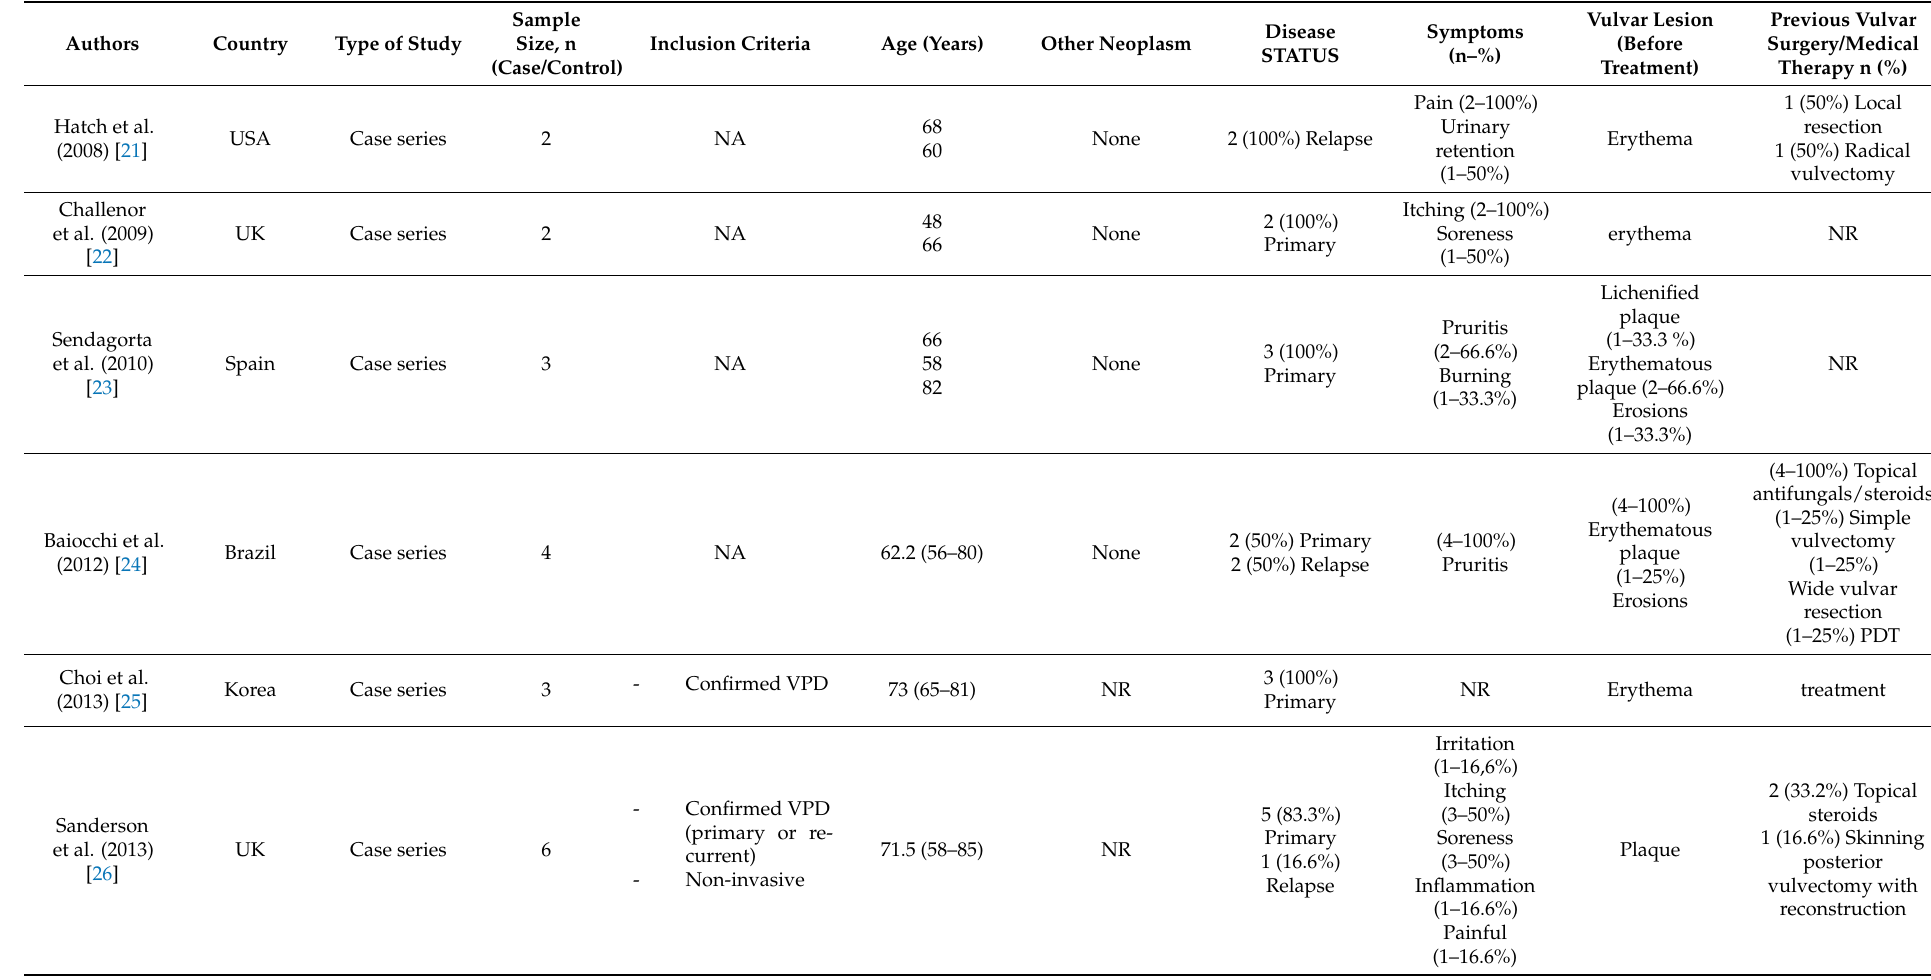
Table 1. Characteristics of the included